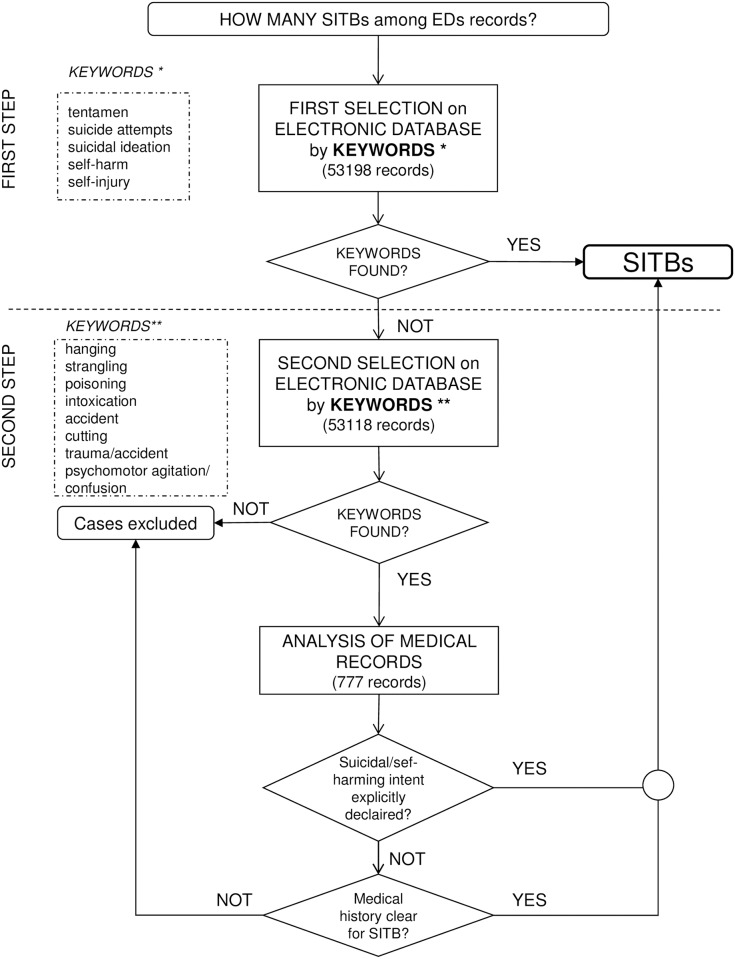
Flow-chart representing the two-steps procedure for the identification of SITBs among the cases visited in the EDs of the Friuli Venezia Giulia Region in the years 2005 and 2006.